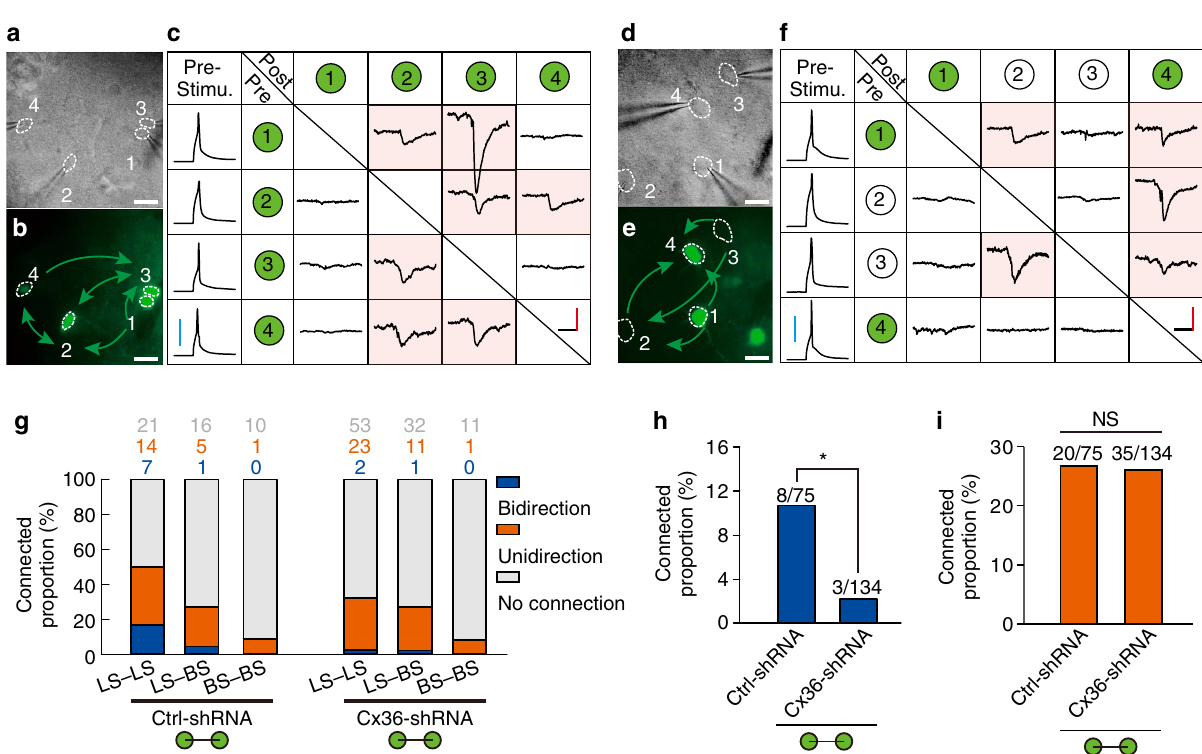
Figure 8 | Electrical coupling is required for the formation of bidirectional chemical synapses between layer 1 interneurons. ( a – f ) Quadruple whole-cell recordings of four layer 1 interneurons in a Ctrl-shRNA ( a – c ) and Cx36-shRNA ( d – f ) slice. DIC ( a , d ) and fluorescence images ( b , e ) of the respective quadruple whole-cell recordings are shown. The green arrows in b and e indicate the direction of chemical synapses. A summary of the chemical synaptic connections detected in the quadruple recordings is also shown ( c , f ). Pink shading indicates the existence of chemical synapses. Scale bar, 20 m m in ( a , b , d , e ), 20pA (red), 40mV (blue) and 15ms (black) in ( c , f ). ‘Pre-Stimu.’, presynaptic potential; ‘Pre’, presynaptic neuron; ‘Post’, postsynaptic neuron. ( g ) Summary of the proportion of chemical synapse formation between layer 1 interneurons in Ctrl-shRNA (GFP þ -GFP þ pairs) and Cx36-shRNA (GFP þ -GFP þ pairs) slices at P9–P25. Green circle indicates GFP þ cells. ( h ) The proportion of bidirectional chemical connections in Cx36-shRNA group was significantly less than in Ctrl- shRNA groups. ( i ) The proportion of unidirectional chemical connections in Ctrl-shRNA and Cx36-shRNA groups showed no significant differences. n ¼ 21 mice for Ctrl-shRNA group, 37 mice for Cx36-shRNA group. * P o 0.05, n.s., not significant, P 4 0.05. w 2 -test, Fisher’s exact